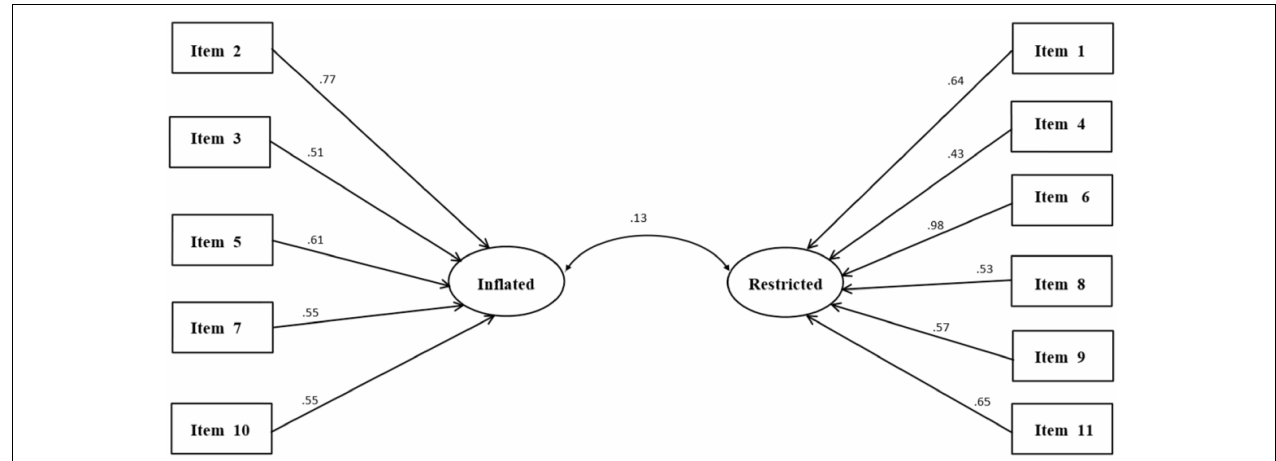
FIGURE 1 | CFA of the two-factor model for the SRE-ao. All paths were statistically significant at p < 0.001. Latent variables are shown by ellipses and observed variables by rectangles. Arrows between latent variables indicate correlations between latent variables. Correlations between latent and observed variables were significant at p < 0.001.